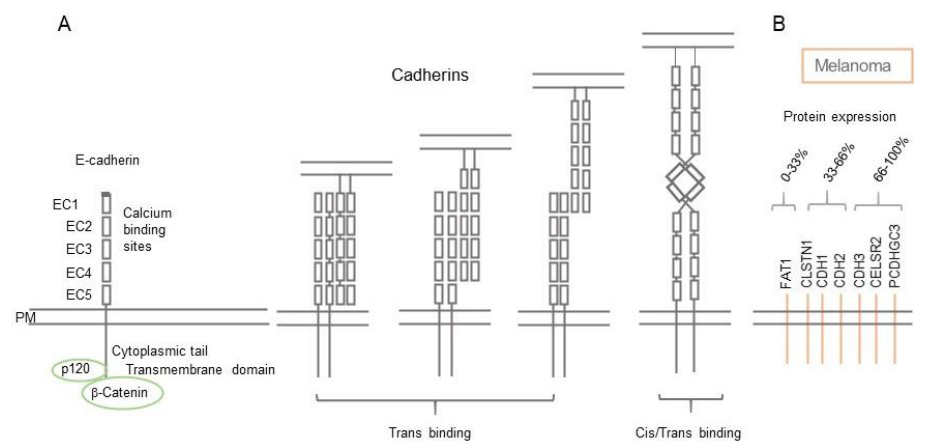
Figure 1. Schematic structure of cadherins and protein expression in melanoma. ( A ) Extracellular and intracellular structure of E-cadherin in trans- and cis -binding conformations. Trans binding refers to the cadherin molecules on one cell binding to cadherin molecules on other cells (cell-to-cell dimerization). Cis binding interfaces form between cadherins from the same cell surface and have been proposed to play a role in cadherin clustering. Intracellular signalling associated proteins are circled in green. ( B ) Cadherin protein expression on melanoma cells obtained from the Human Protein Atlas (immunohistochemistry staining). Staining intensities are estimated based on the percentage of patient samples positively stained for the respective CAM and classified into low (0 – 33% of patients), medium (33 – 66% of patients), and high expression (66 – 100% of patients). See also Table S1.